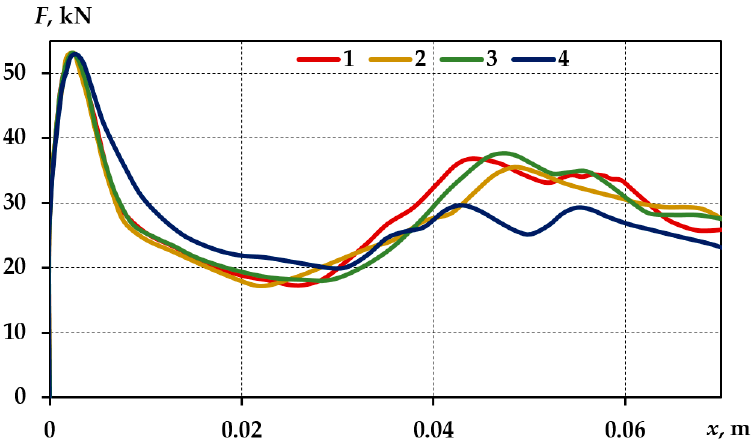
Figure 18. Force—deformation diagrams (FEM) of different types of specimens of section P1; (1— original geometry and original material; 2—0.5 mm geometric deviation and material subjected to plastic deformation; 3—0.5 mm geometric deviation and original material; 4—1 mm geometric deviation and original material).